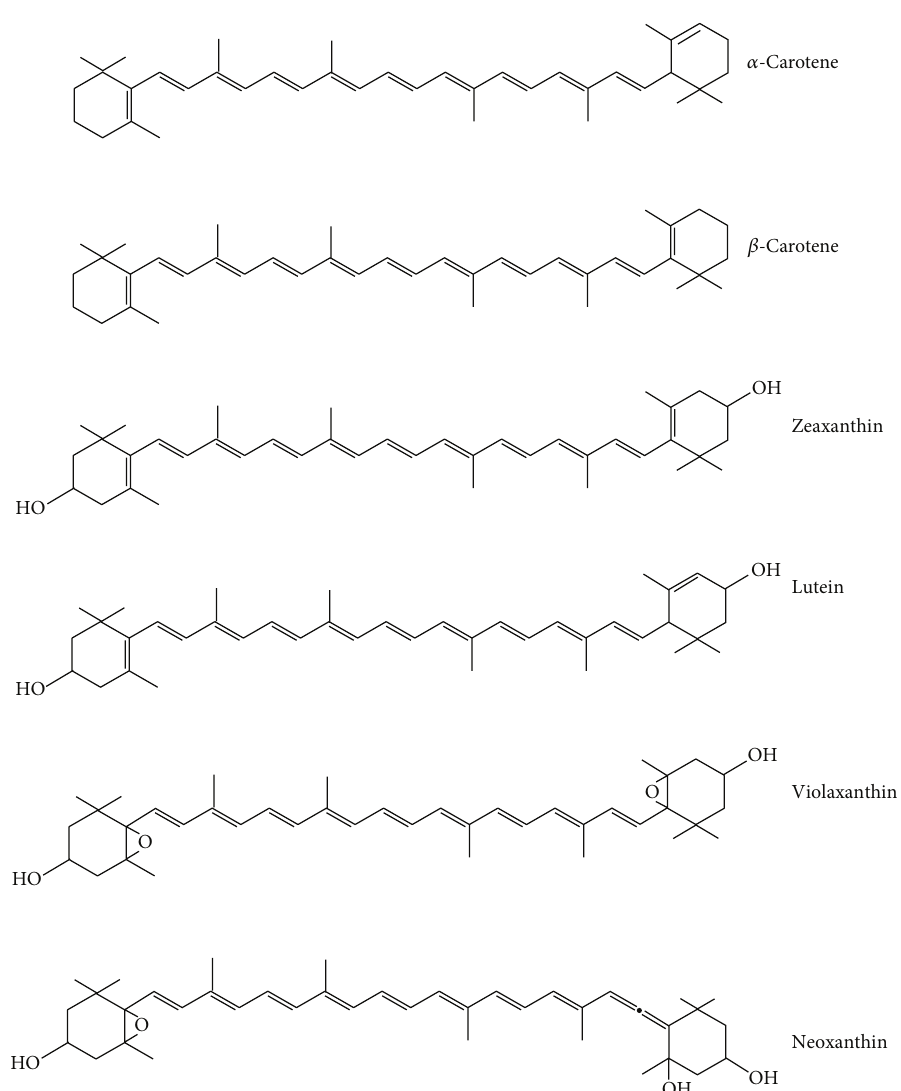
Figure 4: Chemical structure of the main chloroplast carotenoids of higher plants (adapted from